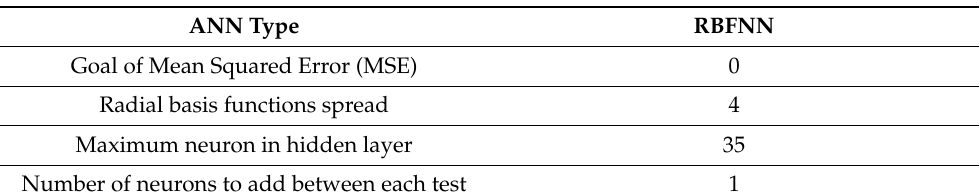
Table 1. Configuration of classifier